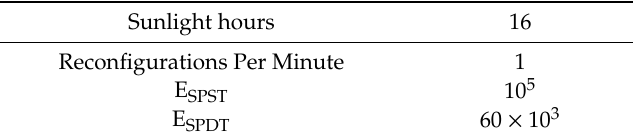
Table 5. Main characteristics of the proposed study case of reconfiguration.